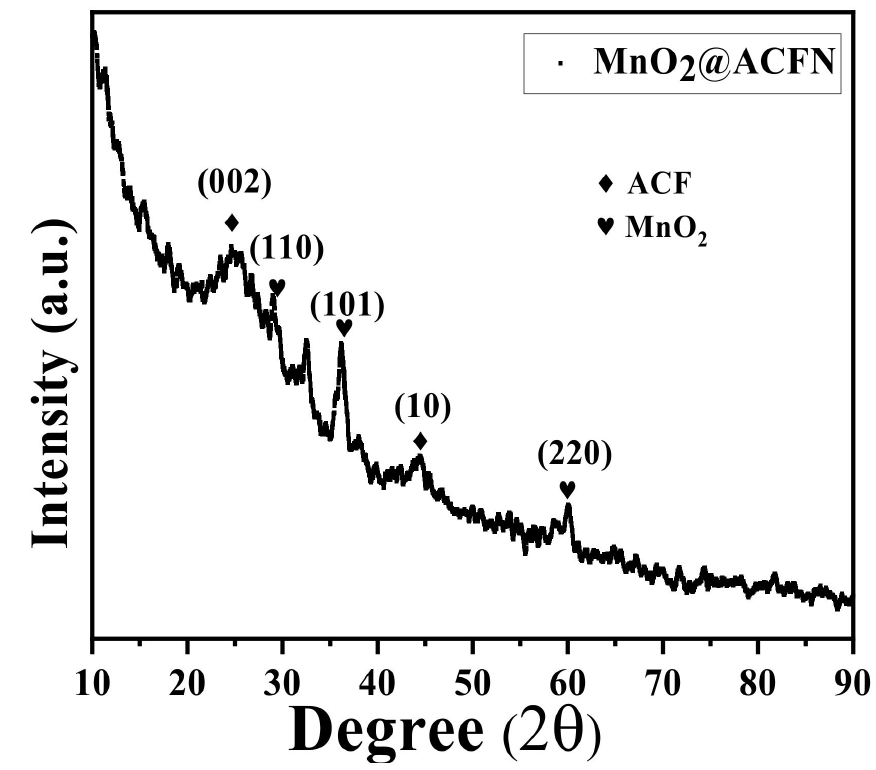
Figure 5. XRD patterns of MnO 2